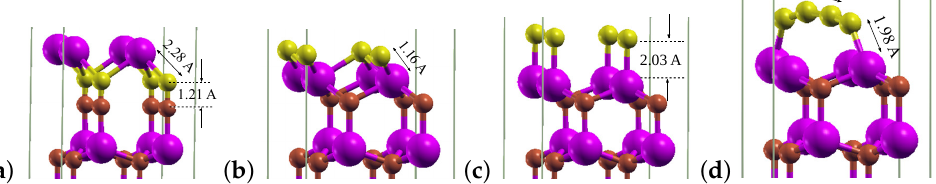
Figure 5. Final adsorption sites of carbon on GaN ( 0001 ) . Coverage: 1 ML; adsorption is initiated in sites: ( a ) T4. ( b ) H3. ( c ) On top. ( d ) Bridge.